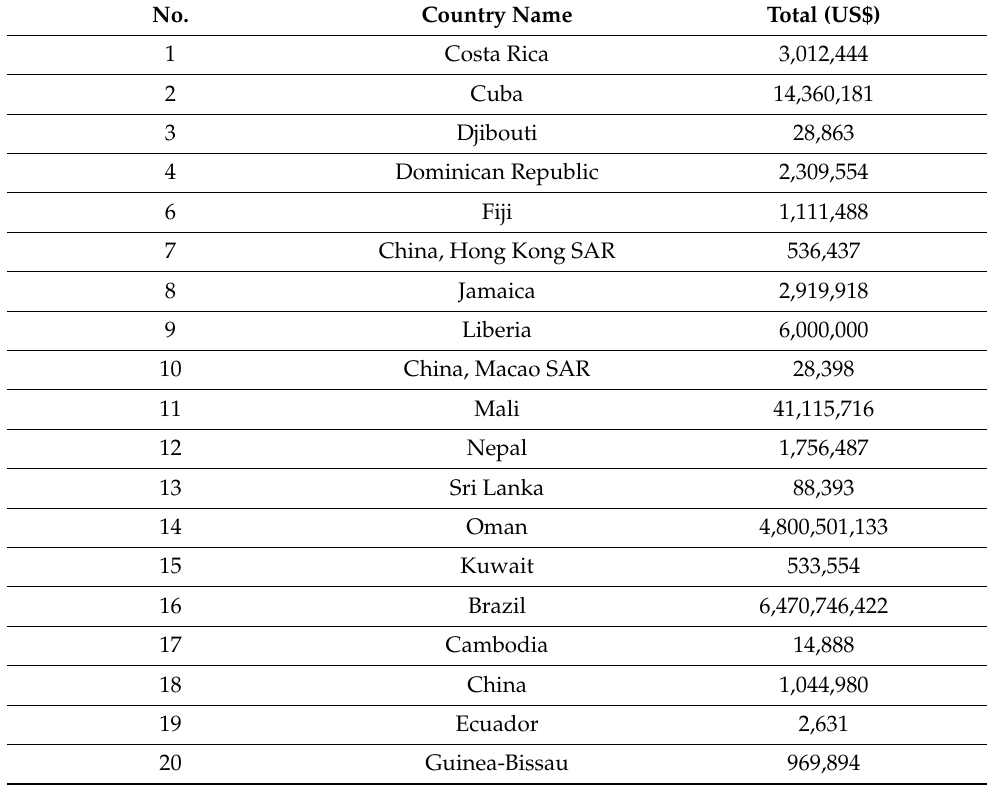
Table 4. Total costs of anticipation policy (US$) in 32 non-crisis